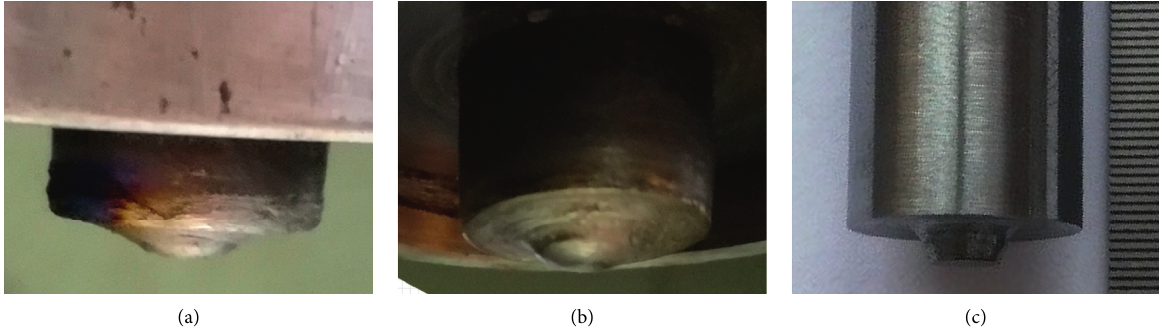
Figure 5: Serious sticking of tool: (a) after welding at 600rpm, (b) after welding at 500rpm, and (c) before welding.